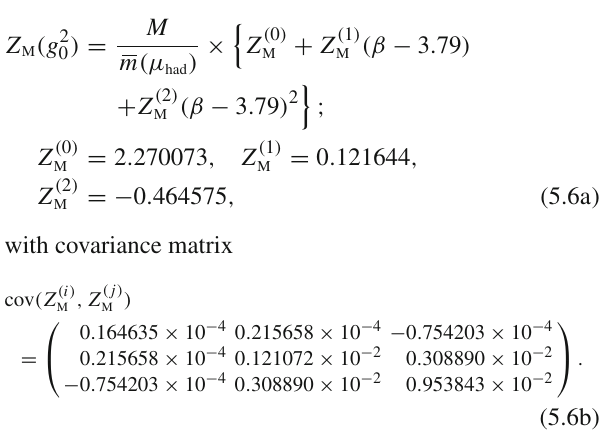
) plane of the fit (grey band) to the Fig. 5 Projection on the (β, Z P results for Z P at the hadronic matching point u had = 9 . 25 (filled red points). The data points have been shifted to the target value of u GF and Lm = 0 using the fit function. Horizontal error bars have been assigned to reflect the uncertainties coming from the value of u GF for each point, / g 2 = (cid:18) u / u by defining (cid:18) g 2 GF GF . Vertical dashed lines correspond to 0 0 the β values of CLS ensembles